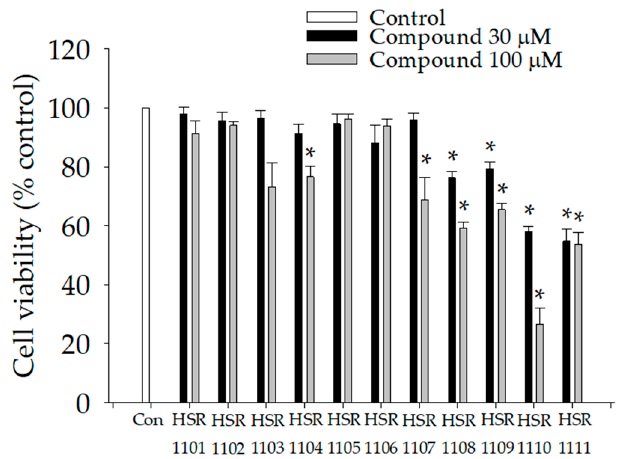
Figure 2. Effects of isoquinoline-1-carboxamides on the viabilities of BV2 cells. BV2 cells were treated with a series of concentrations of these compounds for 24 h. Then, MTT assays were performed, as described in the Materials and methods section. Data are expressed as mean ± SEM of at least three independent experiments. * p < 0.05 vs the vehicle-treated control. Con, control.